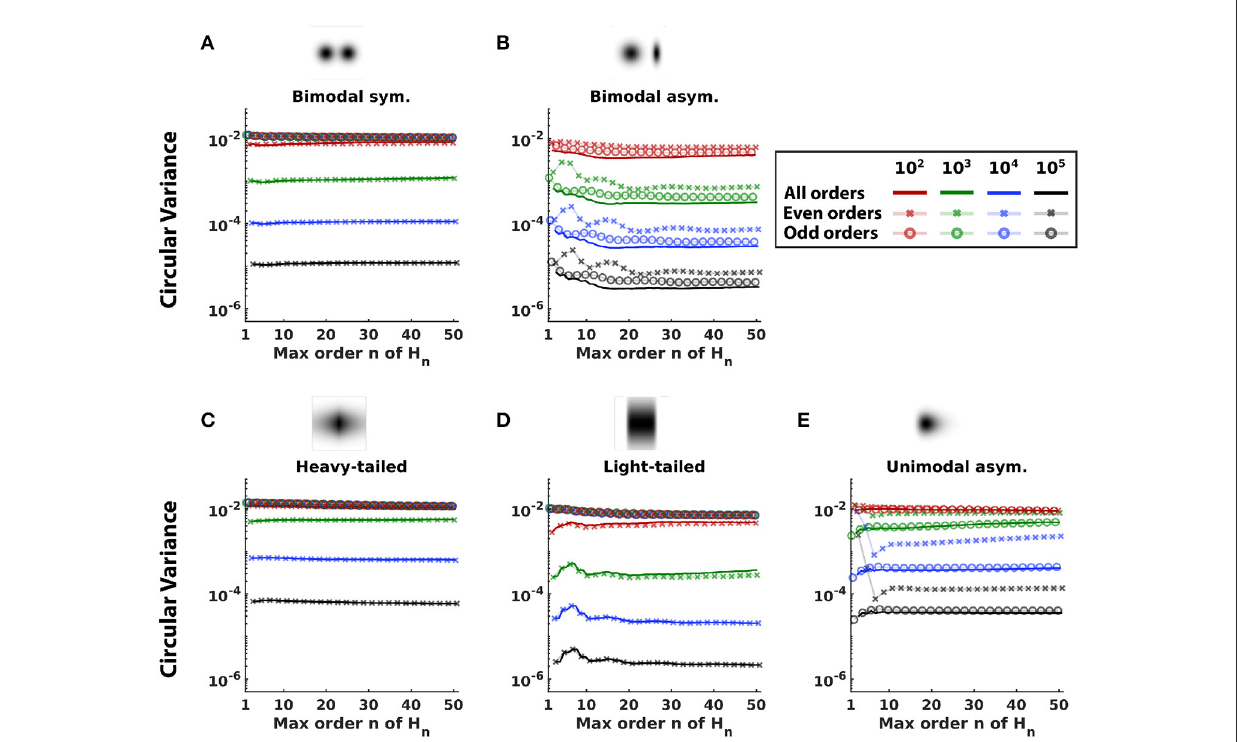
FIGURE4 Comparison of measures of non-Gaussianity constructed with different sets of Hermite functions. Non-Gaussianity was estimated with variants of Equation (9) terminating at a range of values of n (solid lines), and also with variants that included only even (x connected with faint lines), or odd (o connected with faint lines) orders. Distributions are shown at the top. Colors differentiate sample sizes. Curves show the mean of circular variance, a measure of precision. (A) Bimodal symmetric distribution. (B) Bimodal asymmetric distribution. (C) Heavy-tailed distribution. (D) Light-tailed distribution. (E) Unimodal asymmetric